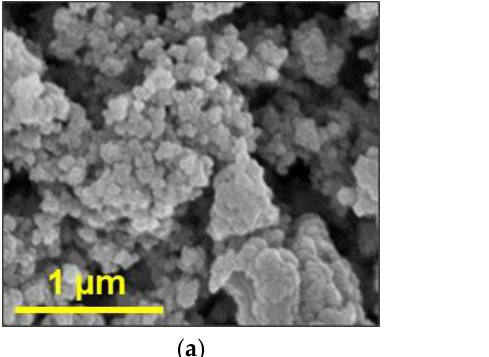
Figure 13. SEM images of polyamides (PA) ( a ) and PA aerogels and carbon (PA-C) ( b ) samples.